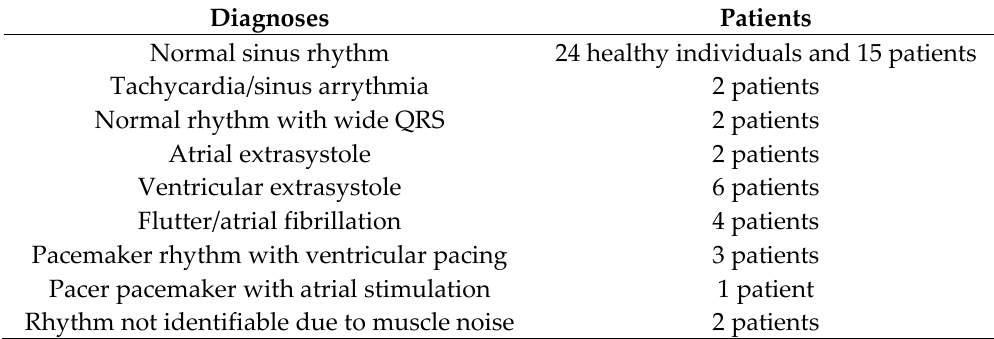
Table 1. Heart rate diagnoses and number of evaluated